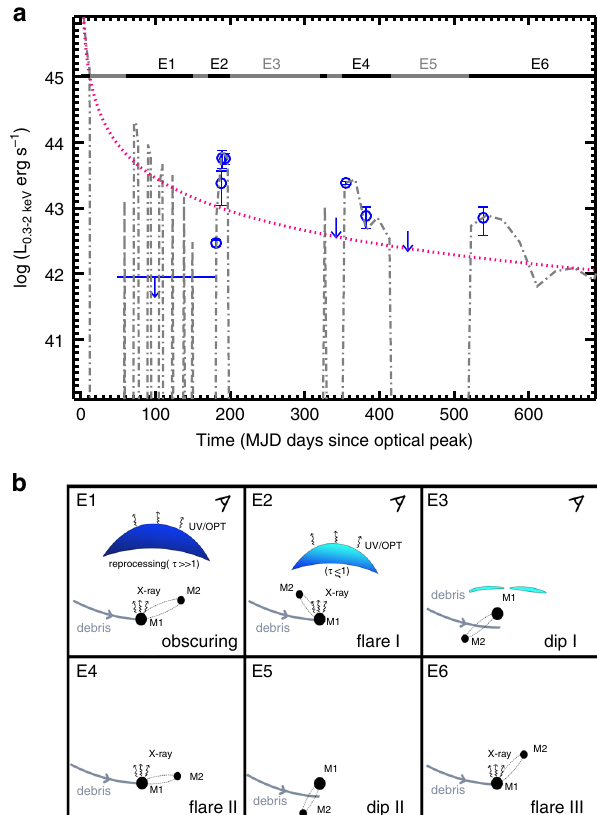
Fig. 5 X-ray luminosity evolution of OGLE16aaa modeled with the tidal disruption by binary black hole. a The observed 0.3 – 2 keV luminosity of OGLE16aaa at different epochs, shown with blue symbols. Error bars correspond to 1 σ uncertainties, as that shown in Fig. 1. The 3 σ upper limits are adopted for X-ray non-detections and shown with downward pointing arrows. Simulated light curve is shown in gray dot-dashed line, for the tidal disruption by binary black hole in the observer frame for OGLE16aaa (Table 3). As there is a time difference between the fallback particles and radiation in simulations, which is 40 days from the best- fi t, the observed light curve is shifted rightward to match the simulated one. The magenta- red dotted line represents the canonical t − 5/3 decay law. Observational data are from Table 1. The horizontal thick lines represent different stages of X-ray evolution, as illustrated in b . b A schematic illustration of the evolution of X-ray emission. E1: The X-ray emission from the inner accretion disk of primary BH is initially obscured by a thick reprocessing layer, by which the X-ray radiation is absorbed and re-emitted at UV/ optical wavelengths; E2: Ionization radiation results in a change in the opacity at later times, and direct escape of X-ray radiation ( fl are I). The reprocessing layer recedes inwards as τ (cid:3) < 1; E3: Due to the perturbation of secondary BH, the infalling stream debris misses the accretion radius, causing interruptions in the light curve (dip I); E4: The accretion continues and X-ray fl are occurs ( fl are II); E5: The infalling debris begins to miss again (dip II); E6: Beginning of another stage with accretion ( fl are